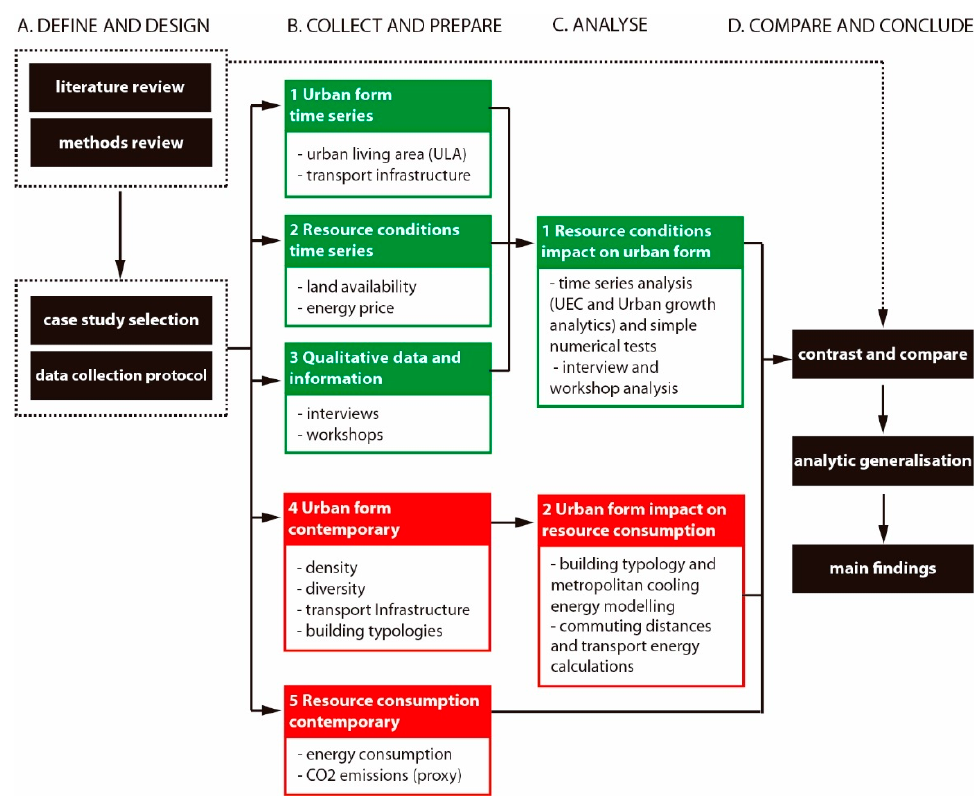
Figure 1. Research framework.